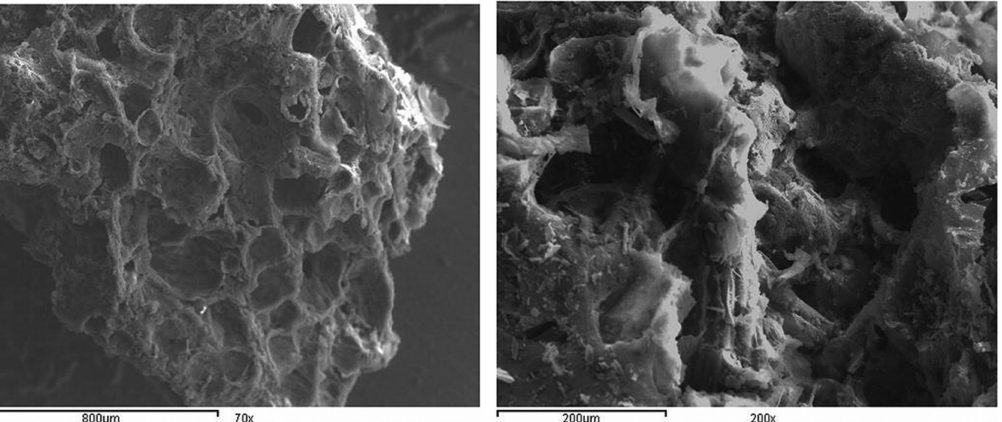
Figure 3. SEM image of SCBAC with 70 × , 200 × ( left ), and 1500 × ( right ). Adapted with permission from Ref.